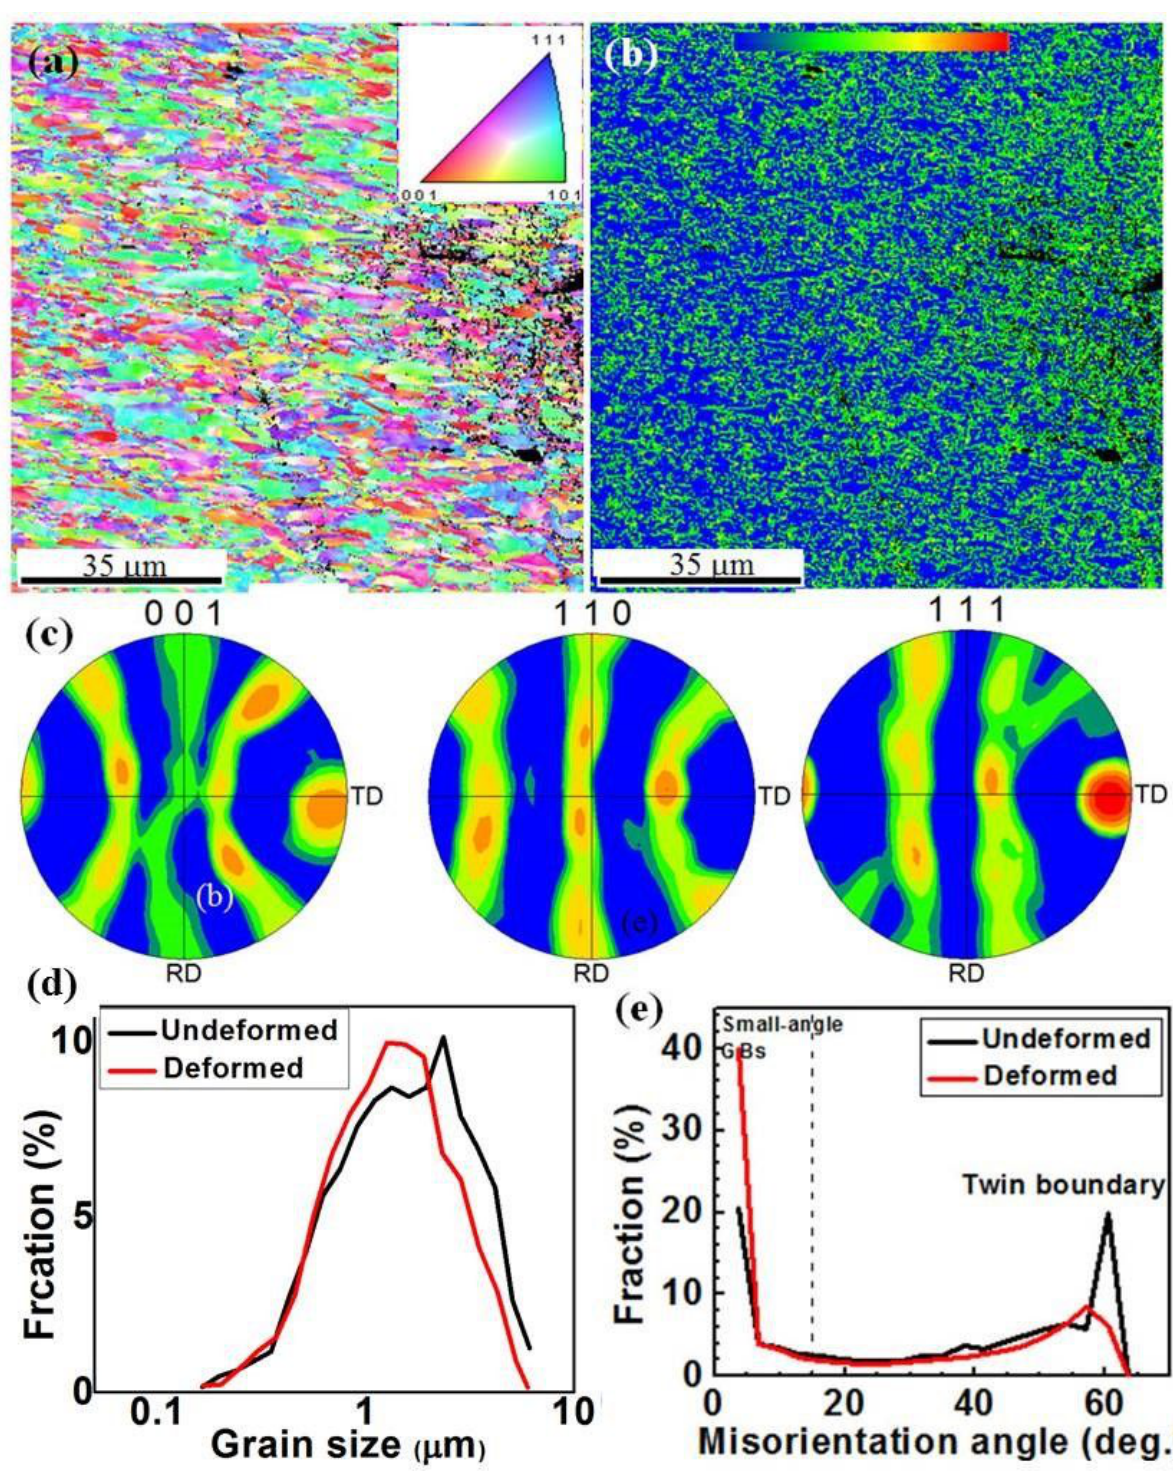
Figure 4: (a) The orientation mapping of bimodal Cu after tensile test; the inset is IPF-Z coloring code. (b) the local average misorientation map of Figure 4(a); (c) the pole figures of Figure 4(a); (d) the grain size distributions of bimodal Cu after and before tensile test; (e) the misorientation angle distributions of bimodal Cu after and before tensile